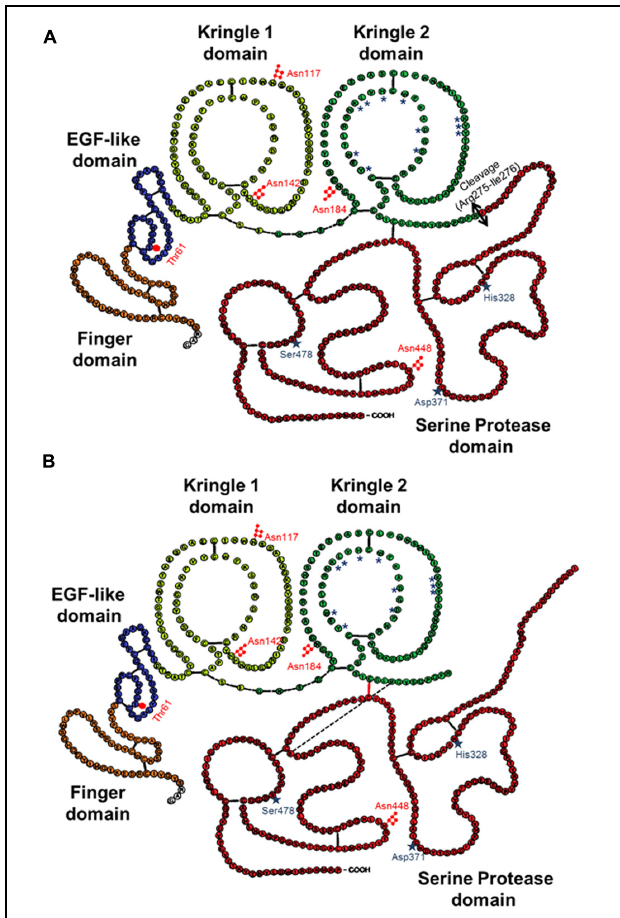
FIGURE 1 | Schematic representations of the primary structure of sc-tPA (A) and tc-tPA (B). Each amino acid is represented by its single letter symbol. Sites of N- ( ) or O-glycosylation ( ) are showed. The active site residues His322, Asp371, and Ser478 are marked by stars. The amino acids involved in the structure of the lysine binding site are noted with asterisks. The black bars indicate disulfide bonds. The black bar dotted indicate salt bond. The double-arrow indicates the cleavage site for conversion of sc-tPA to